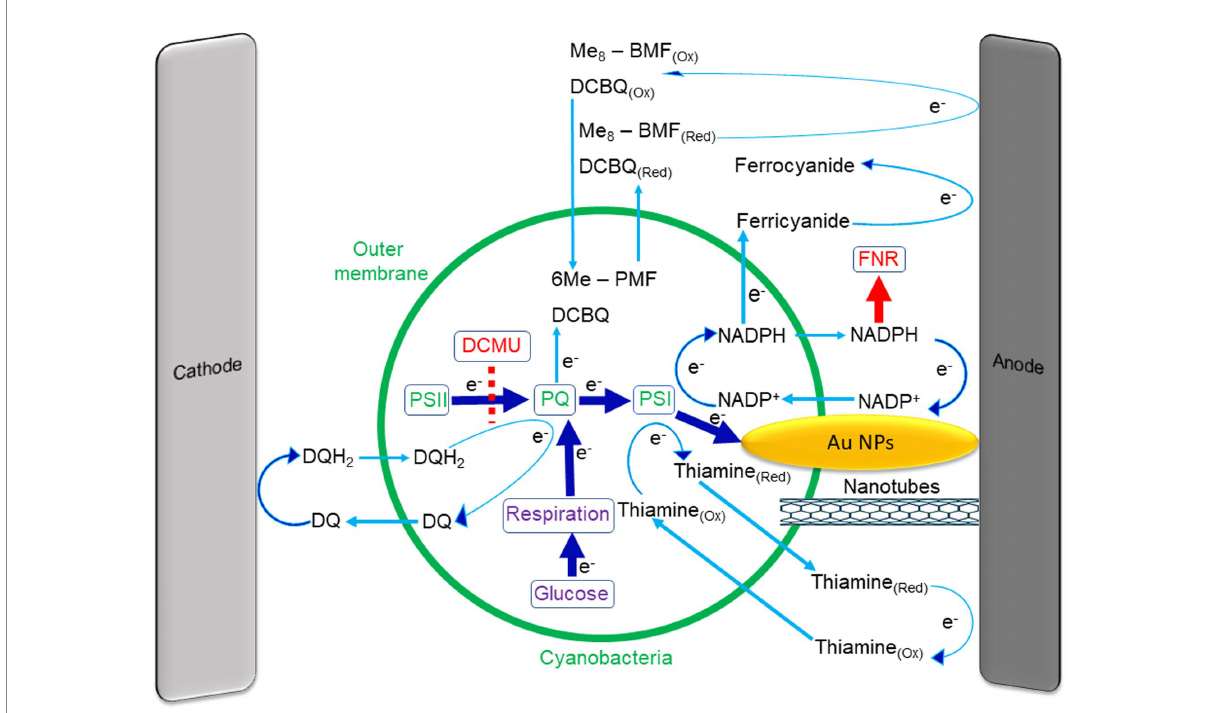
FIGURE 1 Internal and external mediators that are used in cyanobacterial BPECs. In the photosynthetic pathway, electrons are transferred from water via PSII to the plastoquinone pool (PQ) and this is inhibited by the herbicide DCMU (dashed red line). The PQ pool also accepts electrons from